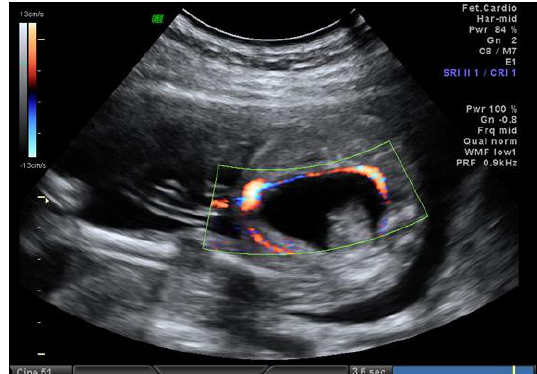
Figure 2: The cystic structure with both umbili- cal arteries around.